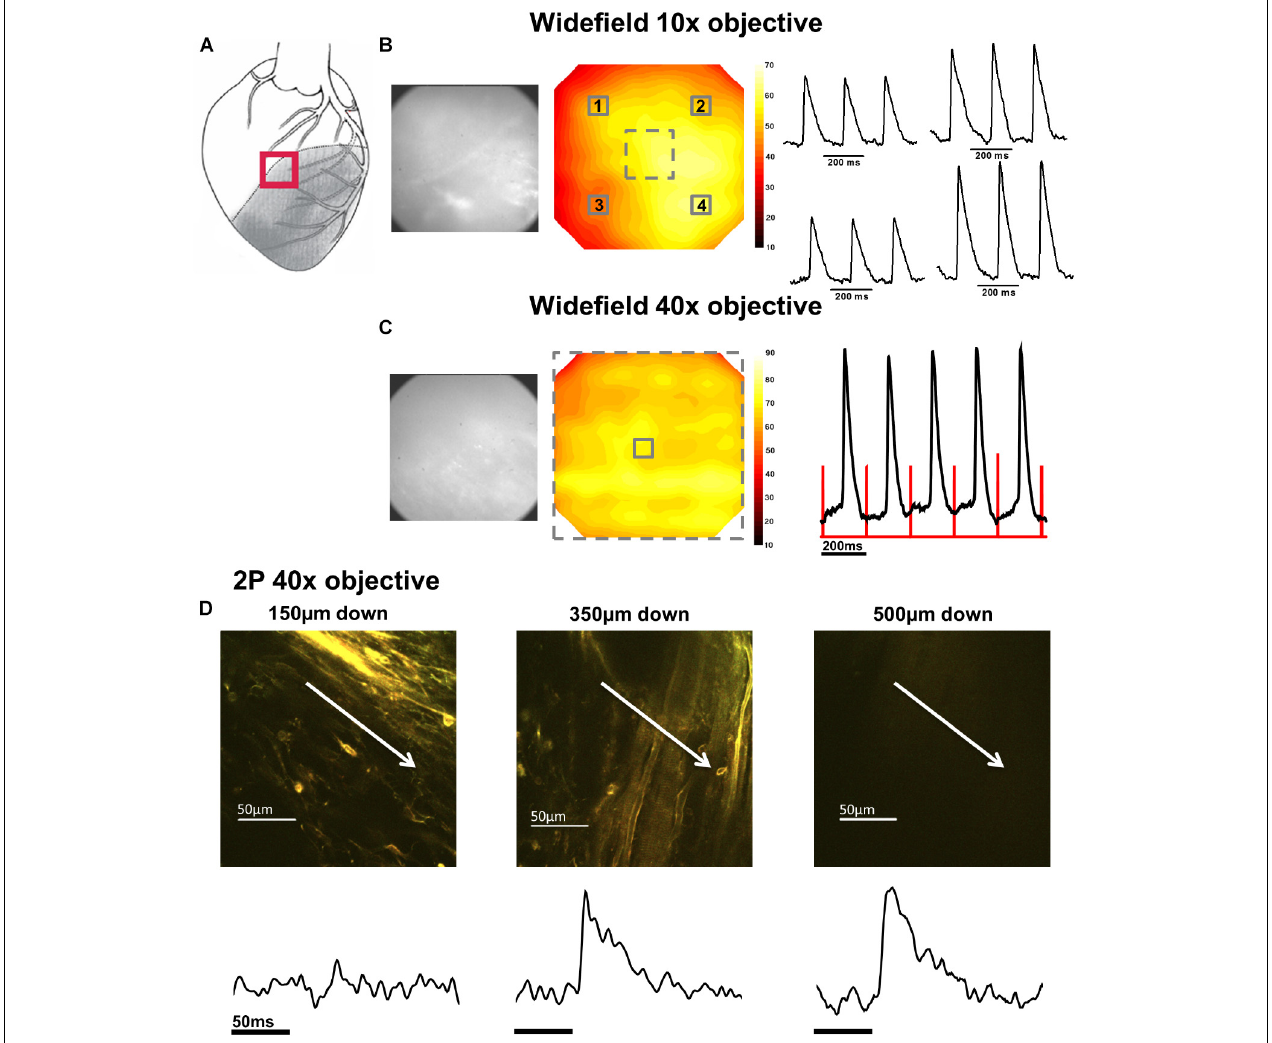
FIGURE 3 | Widefield and 2P signals in the border zone (BZ). (A) Schematic diagram of the infarcted heart. The red square indicates the approximate location of the measurements in the BZ. (B) Widefield measurements taken from BZ tissue using a 10 × objective. From left to right; CMOS camera image of di-4-ANEPPS fluorescence; contour map of di-4-ANEPPS signal-to-noise; 3 × 3 pixel averages (indicated by numbered solid squares in contour map) of action potentials (APs). (C) Measurements were then focused to a smaller area using a 40 × objective [indicated by the dashed square on contour map in (B) ]. From left to right; CMOS camera image of di-4-ANEPPS fluorescence in the BZ; Contour map of signal-to-noise in the 40 × field of view; 3 × 3 pixel average of the AP signal in the center of the optical field, defined by the solid square in the contour map – red lines indicate timing of the stimulus pulse. A series of 2P measurements were made through increasing depth in the same optical field with the 40 × objective. (D) 2P images and corresponding voltage measurement taken at (from left to right) 150, 350, and 500 µ m below the epicardial surface. Myocardial structures could no longer be identified in 2P images at 500 µ m; however, electrical activity was still observed at this depth. White arrows in images indicate approximate length and direction of line scans. All the APs shown are an average of 25 APs recorded over a period of 5 s.